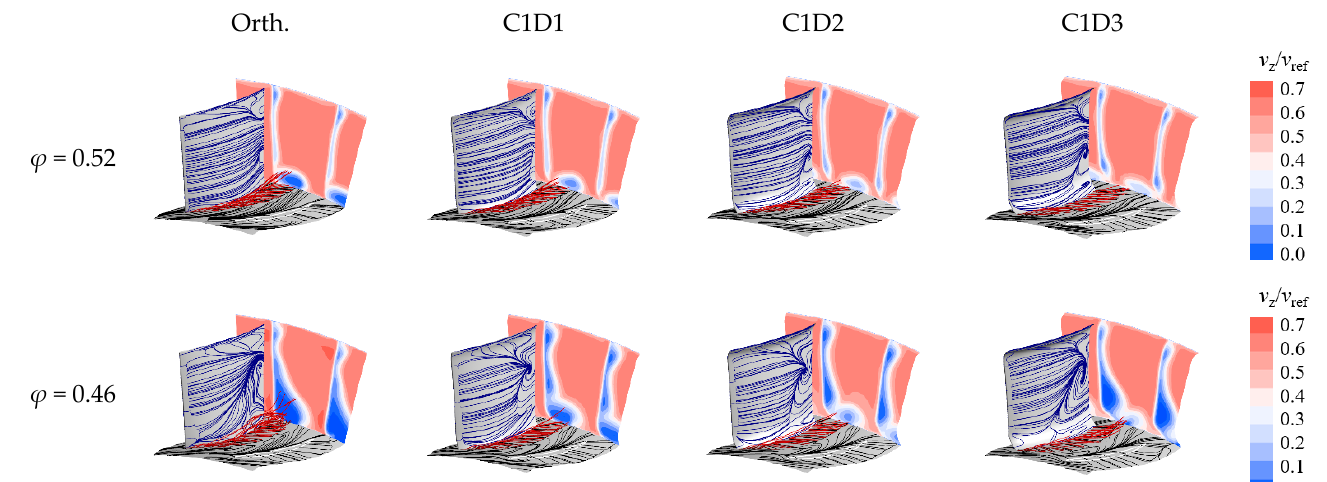
Figure 21. Flow field distribution for the cases with different dihedral angles.